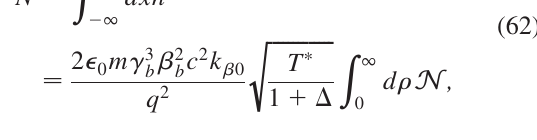
ffiffiffiffiffiffiffiffiffiffiffiffiffi